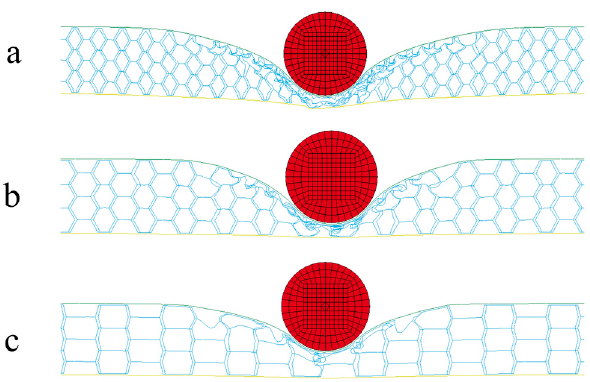
Figure 13. Deformation of the dual-wall honeycomb structure: ( a ) t/l = 0.04, θ = 30°; ( b ) t/l = 0.05, θ = 30°; ( c ) t/l = 0.07, θ = 15°.